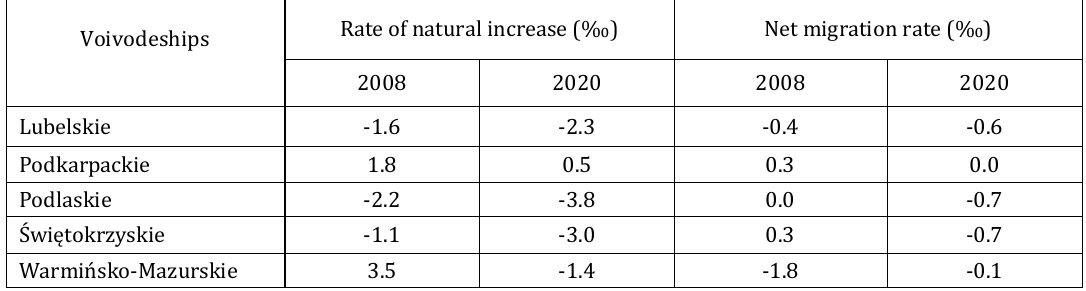
Table 3. The rate of natural increase population and net migration rate in rural areas of Eastern Poland in 2008 and 2020 (Source: calculations of the authors based on data from the Local Data Bank of Statistics, Poland) Voivodeships Rate of natural increase (‰) Net migration rate (‰)